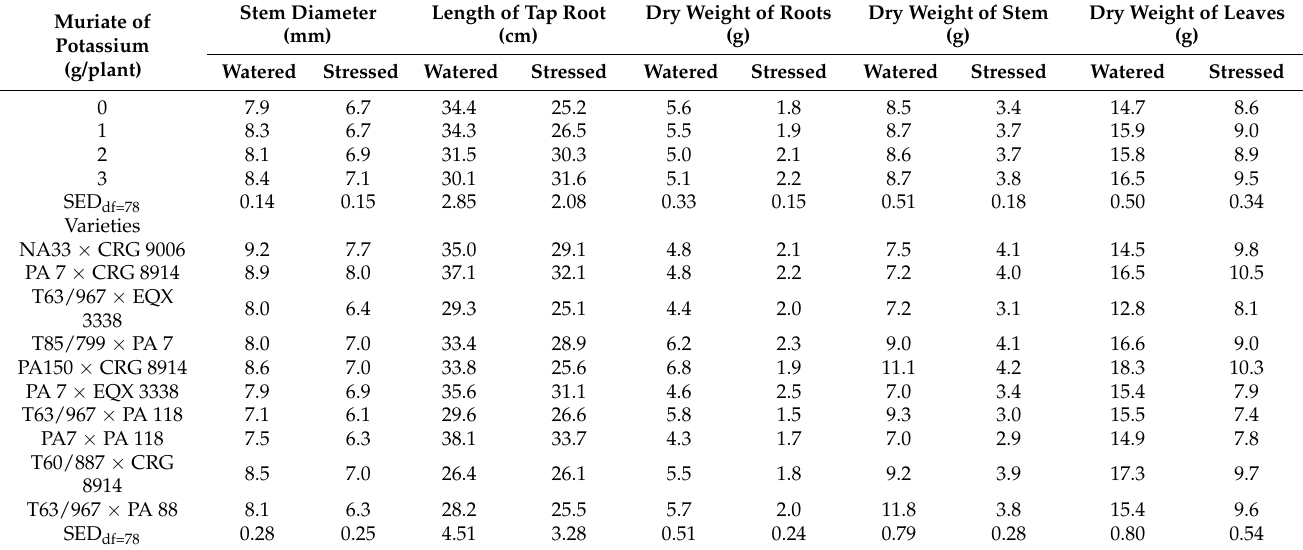
Table 4. Allometric relationships of ten cocoa seedling varieties as influenced by watering regime and potassium treatments 45 days after water stress imposition in experiment